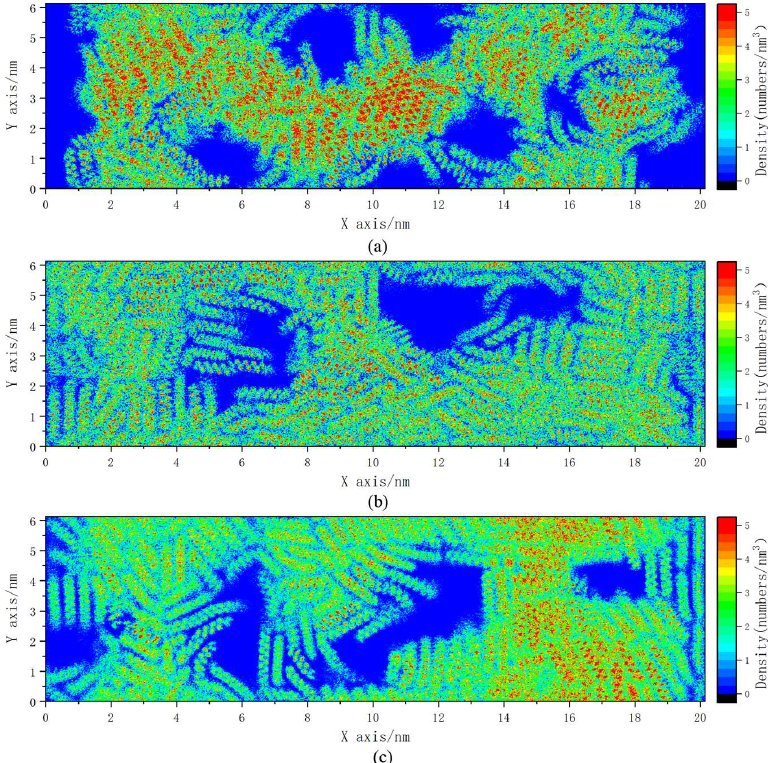
Figure 9. Average 2D numerical density of the oil film of the compound collectors of ( a ) OA:DD